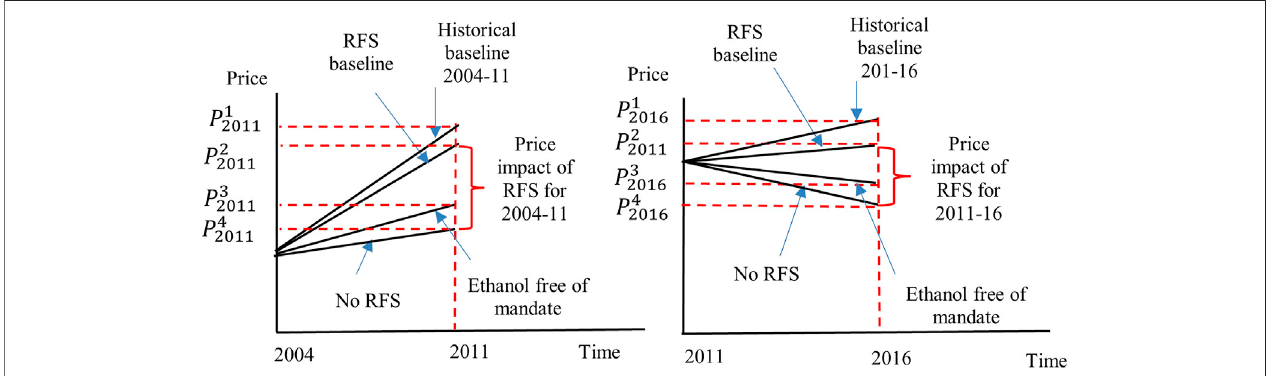
FIGURE2| Aschematicrepresentationofhistoricalbaselinesandcounterfactualexperiments including:FRS Baselines , ethanolfreeofmandate ,and noRFS .The leftpanelrepresents2004 – 11and therightpanel2011 – 16.Theverticalaxisshowsthepriceofarepresentative product.P 1 ,P 2 ,P 3 ,andP 4 indicatetheprojectedprices of this product for the historical baselines , RFS Baseline , ethanol free of mandate , and No RFS experiments, respectively.